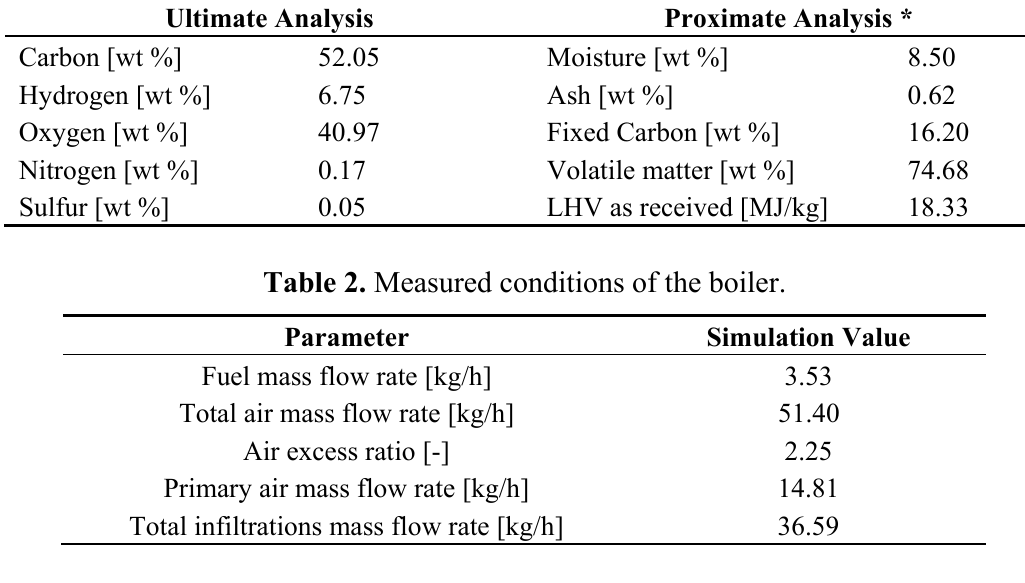
Figure 2. Diagram of the interaction between the bed model and the CFD